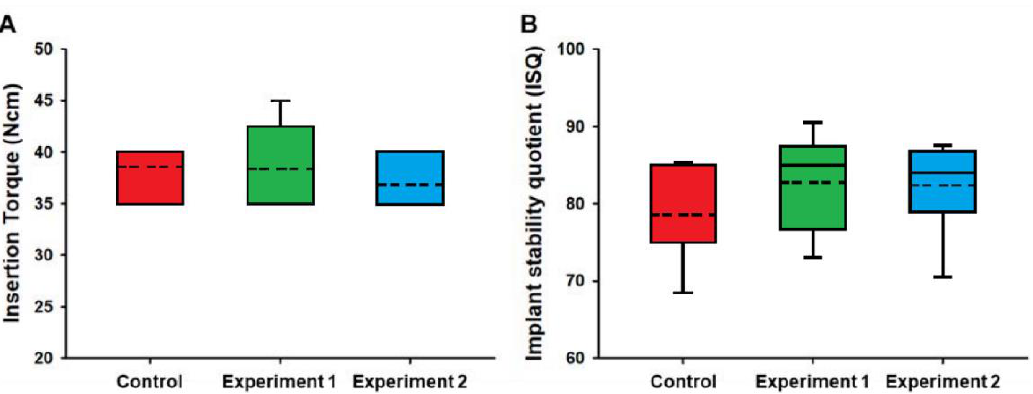
Figure 6. Box graph of primary stability between control, experiment 1, and experiment 2. ( A ): insertion torque ( P = 0.519, Kruskal–Wallis test); ( B ): implant stability quotient (ISQ) ( P = 0.391, Kruskal–Wallis test). In this clinical study, the insertion torque values and ISQ values in all patients met the inclusion criteria. The insertion torque values were similar in the three groups ( P = 0.559). The ISQ value was lower in the control group than in experiment group 1 or 2, but there were no statistical di ff erences ( P = 0.389).